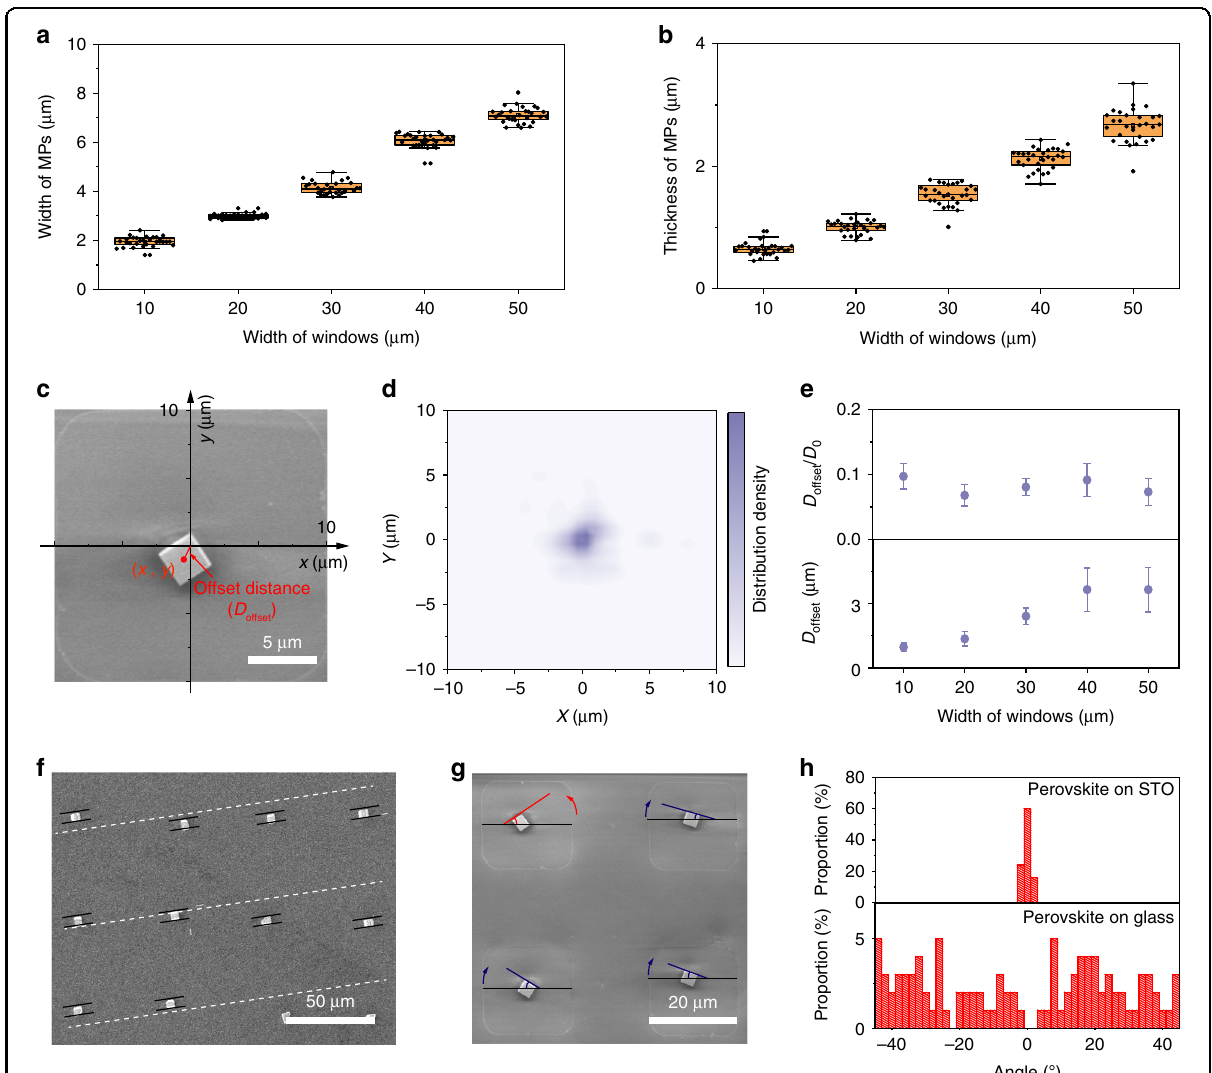
Fig. 2 Demonstration of the controlled growth of perovskite MPs array. The dependence of a width and b thickness of perovskite MPs on the width of the hydrophilic window. c Coordinate system of a perovskite MP in a hydrophilic window with a width of 20 μ m. d Position distribution of 100 perovskite MPs in the coordinate system. e The dependence of D offset and D offset /D 0 on the width of the hydrophilic window. f SEM image of CsPbBr 3 MPs array synthesized on STO (100) substrate. g Schematic of two rotation angles of perovskite MPs considering the clockwise rotation as positive direction (blue) and the counterclockwise rotation as negative (red). h Statistics of the in-plane rotation of 100 perovskite MPs array synthesized on glass and STO (100)